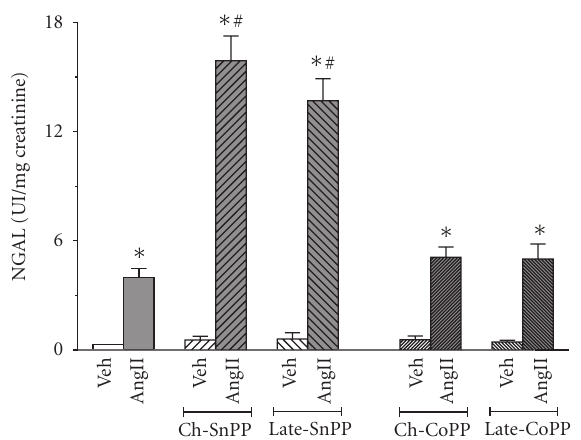
Figure 4: E ff ect of SP-Ang II and HO modulation on the inflammatory cytokine- IL-6 was estimated in the following groups; Vehicle (Veh) treated ( n = 6), SP-AngII-treated ( n = 6), chronic- SnPP- (Ch-SnPP-) treated ( n = 6), SP-AngII/Ch-SnPP-treated ( n = 6), late-SnPP-treated ( n = 5), SP-AngII/late-SnPP-treated ( n = 5), chronic-CoPP- (Ch-CoPP-) treated ( n = 6), SP-AngII/Ch-CoPP– treated ( n = 6), late-CoPP-treated ( n = 5), SP-AngII/late CoPP- treated ( n = 6) rats. ∗ P < 0 . 05 versus. control, # P < 0 . 05 versus. SP-AngII.